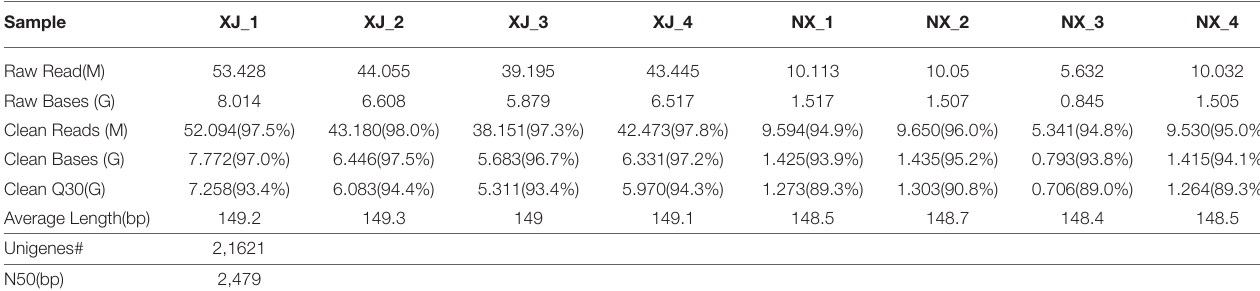
TABLE 1 | Summary statistics of the Metopolophium dirhodum (Walker) transcriptomes.